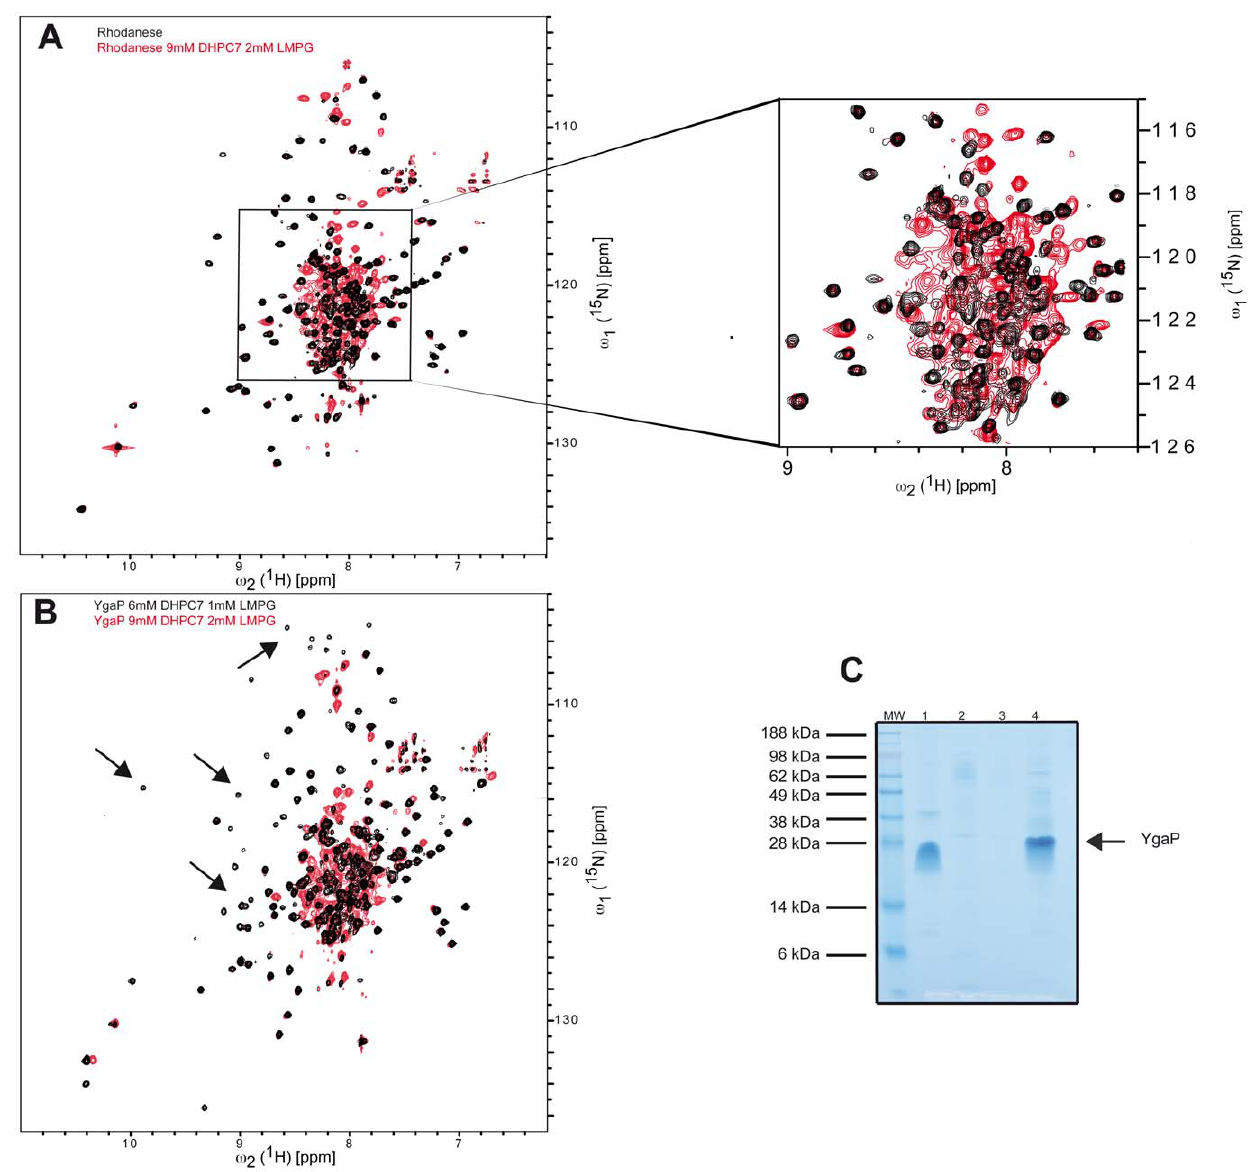
Figure 2. Effects of DHPC-7/LMPG mixed micelles on the N-terminal rhodanese domain and full length YgaP 2 . ( A ) 2D [ 15 N, 1 H]-TROSY spectra of the N-terminal rhodanese domain in absence (Black) and in presence of 9 mM DHPC-7, 2 mM LMPG (Red). For better clarity a portion of the spectrum is magnified as indicated. ( B ) 2D [ 15 N, 1 H]-TROSY spectra of 2 H, 15 N-labeled of YgaP with optimum detergent concentration (i.e. 6 mM DHPC, 1 mM LMPG) (Black) and in presence of 9 mM DHPC-7, and 2 mM LMPG, respectively (Red). Black arrows indicate regions of the red spectrum where resonances are missing, indicating the effect of detergent excess in the quality of the spectrum. ( C ) SDS-PAGE of the nickel affinity purification of YgaP 2 in DHPC-7/LMPG. 4–12% NuPAGE Bis-Tris gel (Invitrogen, Carslbad). Lanes: (MW) SeeBlue plus2 prestained (Invitrogen, Carslbad), (1) YgaP 2 after membrane extraction in DHPC-7/LMPG micelles, (2) Loading flow-through fraction of Nickel resin, (3) Washing of Nickel resin, (4) Elution of YgaP 2 with buffer containing 500 mM imidazole (details of the buffer used are given in the Material and Methods section).